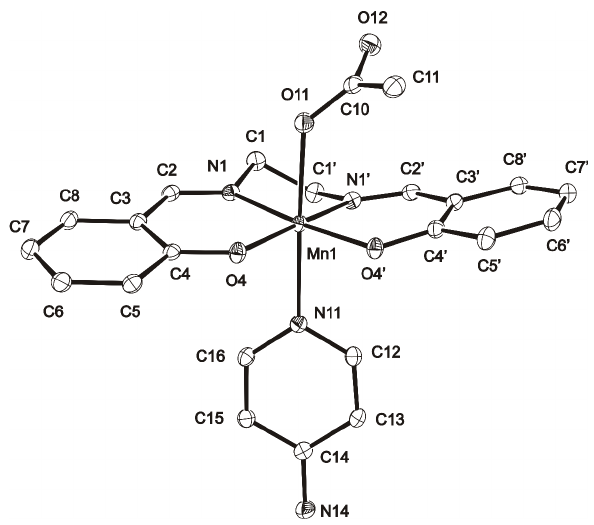
Figure 1. An ORTEP view of a compound 1 , [ Mn(ac)(4-apy)(sal) ] , showing 30% probability ellipsoids and the labeling scheme for non-hydrogen atoms. Hydrogen atoms are omitted for clarity.